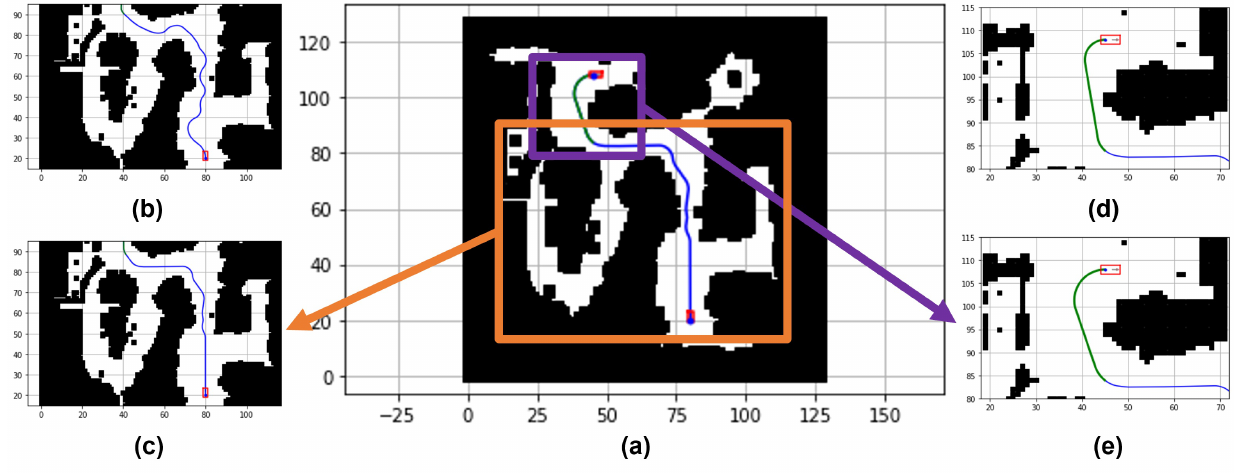
Figure 9. Improved hybrid A-star in a benchmark map den520d . ( a ) Improved hybrid A-star. ( b ) Be- fore tunings. ( c ) After tunings. ( d ) Original RS path. ( e ) Improved RS path.